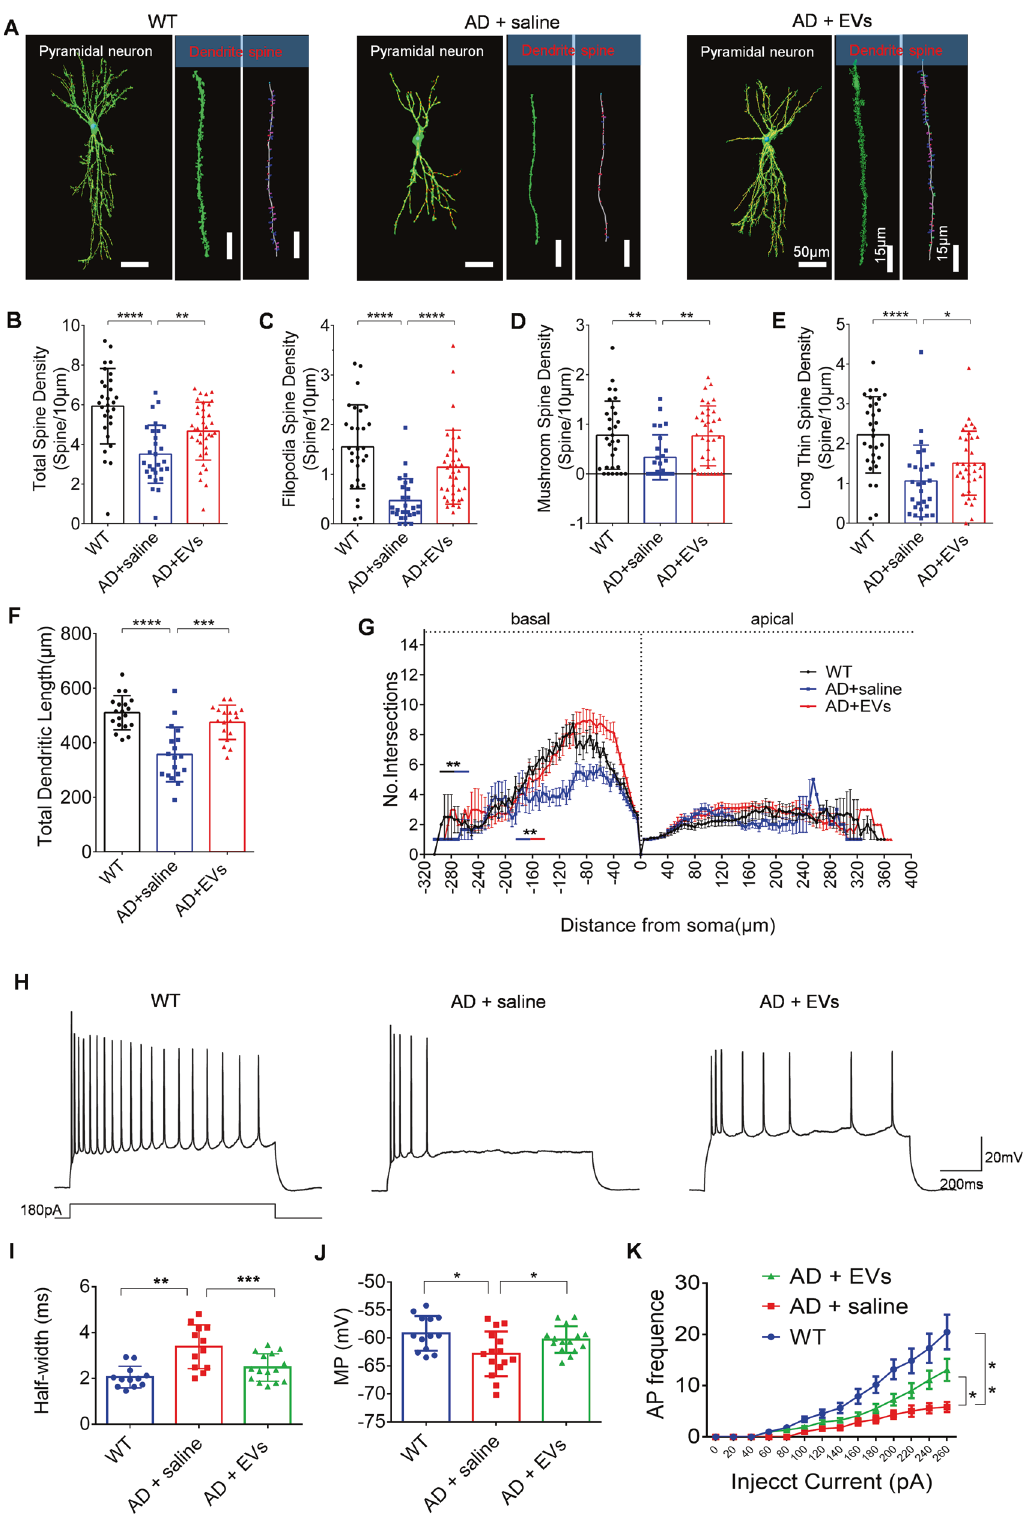
Fig. 5 MSC-EVs administration restores the hippocampal neuronal morphology and function in mice. A Images show the 3D reconstruction of dendritic spine and dendritic phenotype for the hippocampal neurons in the WT, AD + saline, and AD + EVs group (left bar = 50 μ m; right two bars = 15 μ m). B – E Imaris analysis of spines along basal dendrites including total spine density ( B ), fi lopodia spine density ( C ), mushroom spine density ( D ), and long thin spine density ( E ) of three groups. F , G Statistical analysis of total dendritic length ( F ) and dendritic intersections ( G ) in the panel. H Trace images show the waveform of the pyramidal neurons in each group. I – K Histogram represent the statistical data of half-width ( I ), neuronal membrane potential (MP) ( J ), and action potential (AP) frequency ( K ) in each group ( n = 15 per group). The values represent as Mean ± SEM. The data meet normal distribution and the variance is homogeneous. * P < 0.05, ** P < 0.01, *** P < 0.001, **** P < 0.0001. Cell Death Discovery (2021)